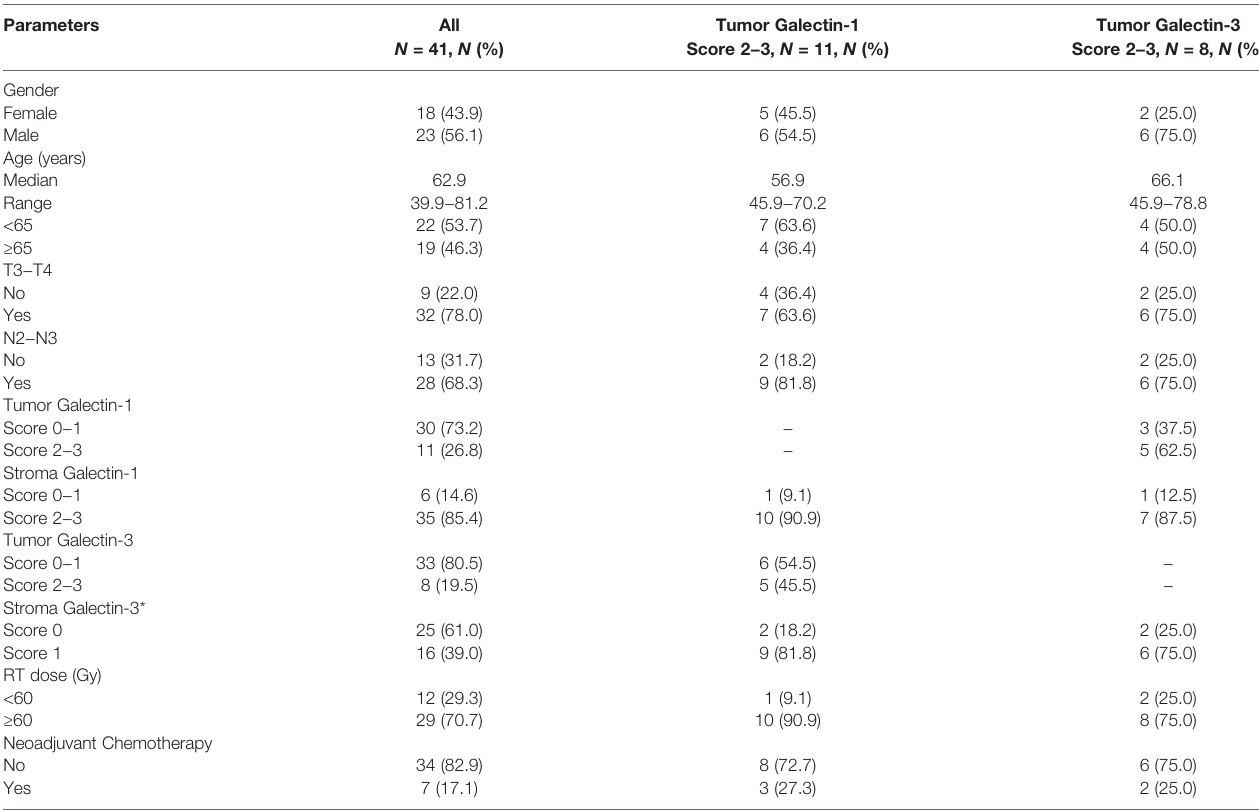
TABLE 1 | Patient characteristics ( N = 41).